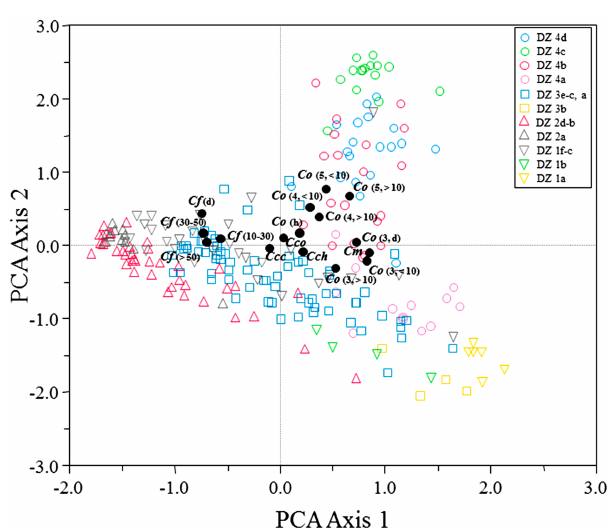
Figure 3. Biplot of PCA Axis 1 vs. PCA Axis 2 sample and species scores from Lake Ohrid DEEP site core (5045-1). Symbol keys for diatom zones and sub-zones in top right corner. Selected di- atom taxa and morphological splits of Cyclotella fottii ( Cf , size in µm) and Cyclotella ocellata ( Co ) are plotted, where numbers in brackets refer to size splits (µm) and ocelli number in C. ocel- lata . Explanation: Cm = Cyclotella minuscula , Cch = Cyclotella cf. hustedtii , Ccc = Cyclotella cf. costei , Cco = Cyclotella cf. ocel- lata , (d) =